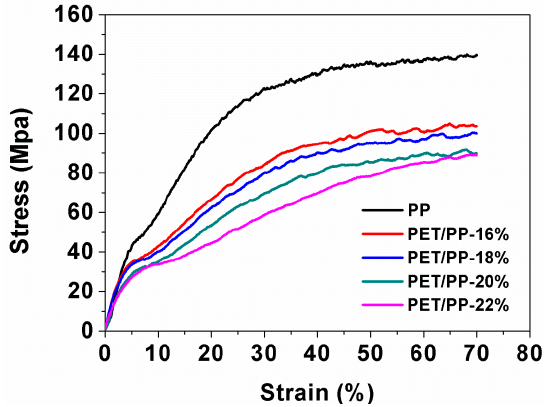
Figure 6. Stress–strain curves of PP separator and the PET/PP separators.